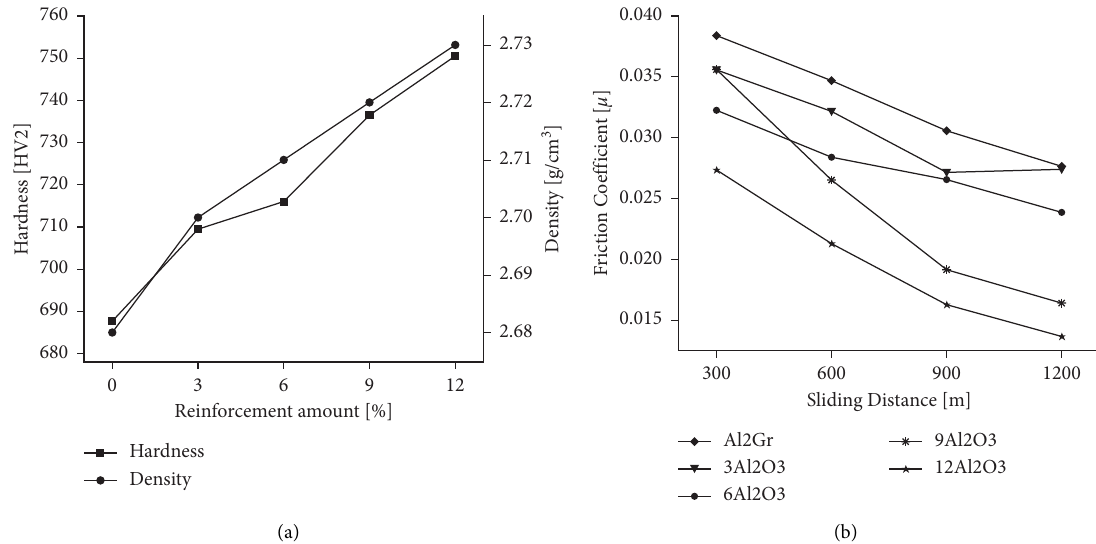
Figure 18: 'e influence of Al 2 O 3 content (a) on hardness and density and (b) on friction coefficient of Al-2 vol% Gr-(3–12 vol%) Al 2 O 3 [68].